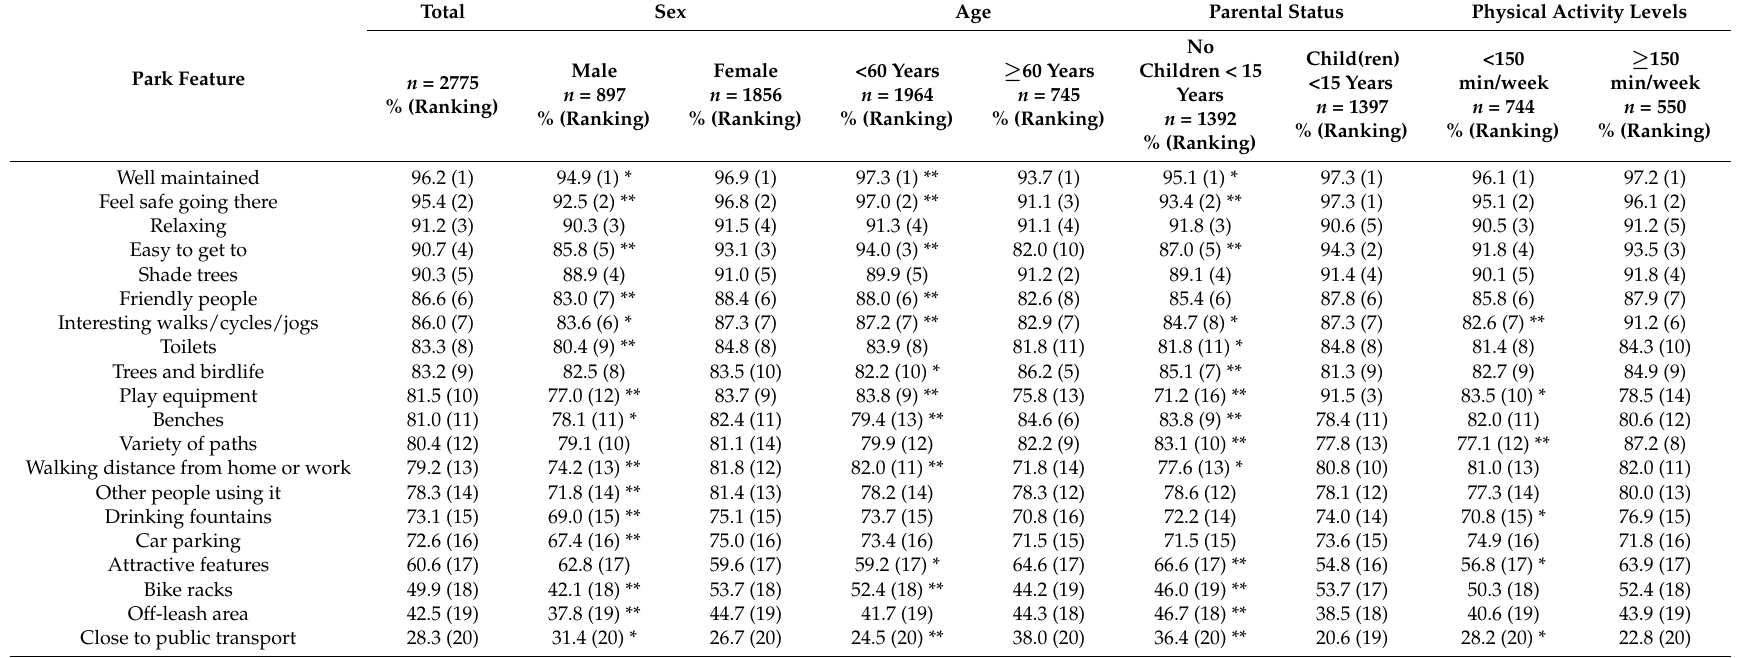
Table 2. The importance (%) and ranking of park features for engaging in physical activity in the next two weeks.